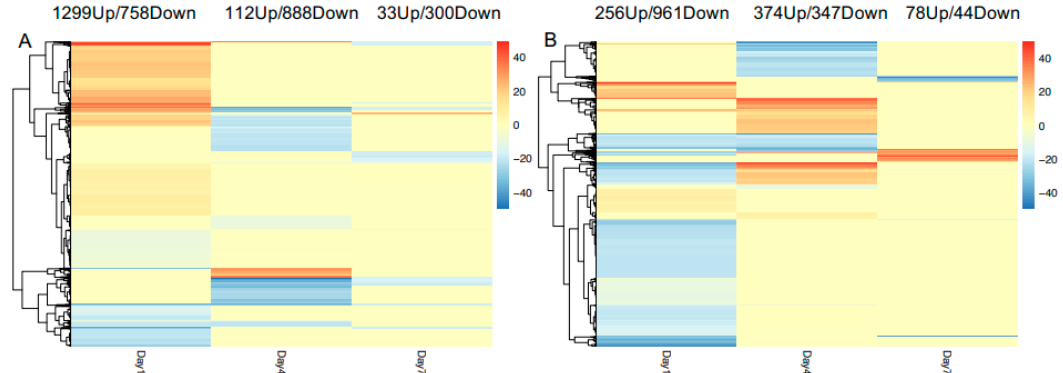
Figure 3. Heatmap of DEG between inoculated and uninoculated samples for each cultivar at 1, 4, and 7 days post-inoculation. ( A ): resistant cultivar; ( B ): susceptible cultivar. Up(red) and Down(blue) regulated genes are those with significantly higher and lower expression in inoculated samples, respectively. The number of the legend indicates log2 fold change.